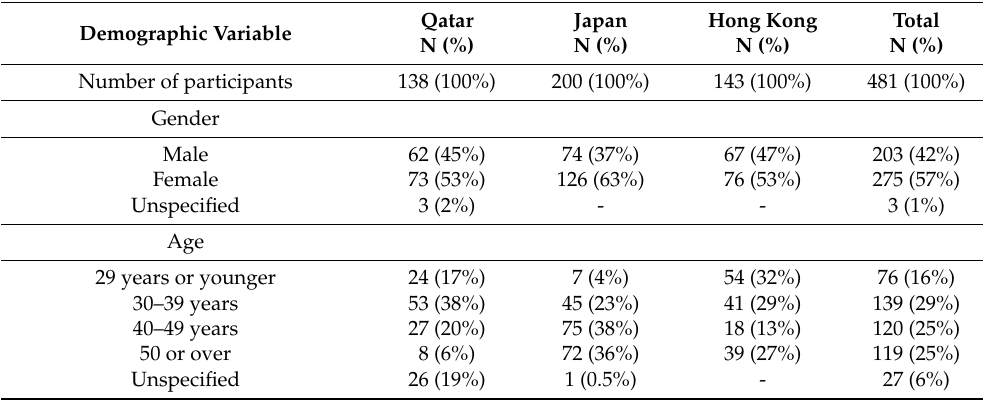
Table 1. Demographic